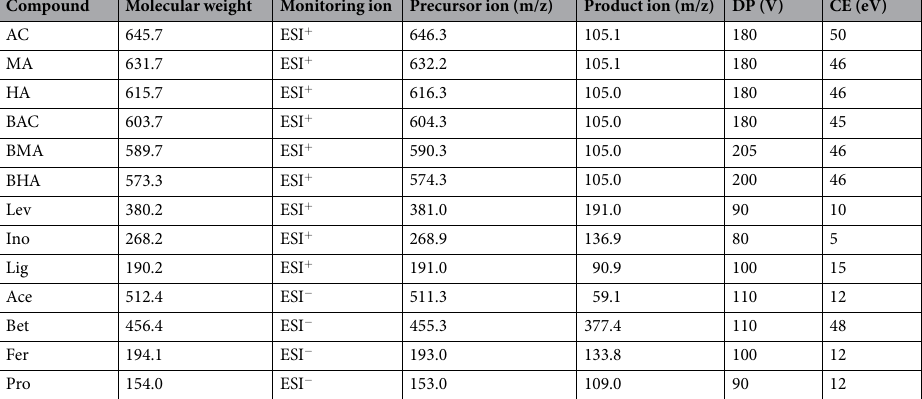
Tablet 3. Summary of molecular weight, multiple-reaction monitoring transitions, DP and CE of the 13 components determined by